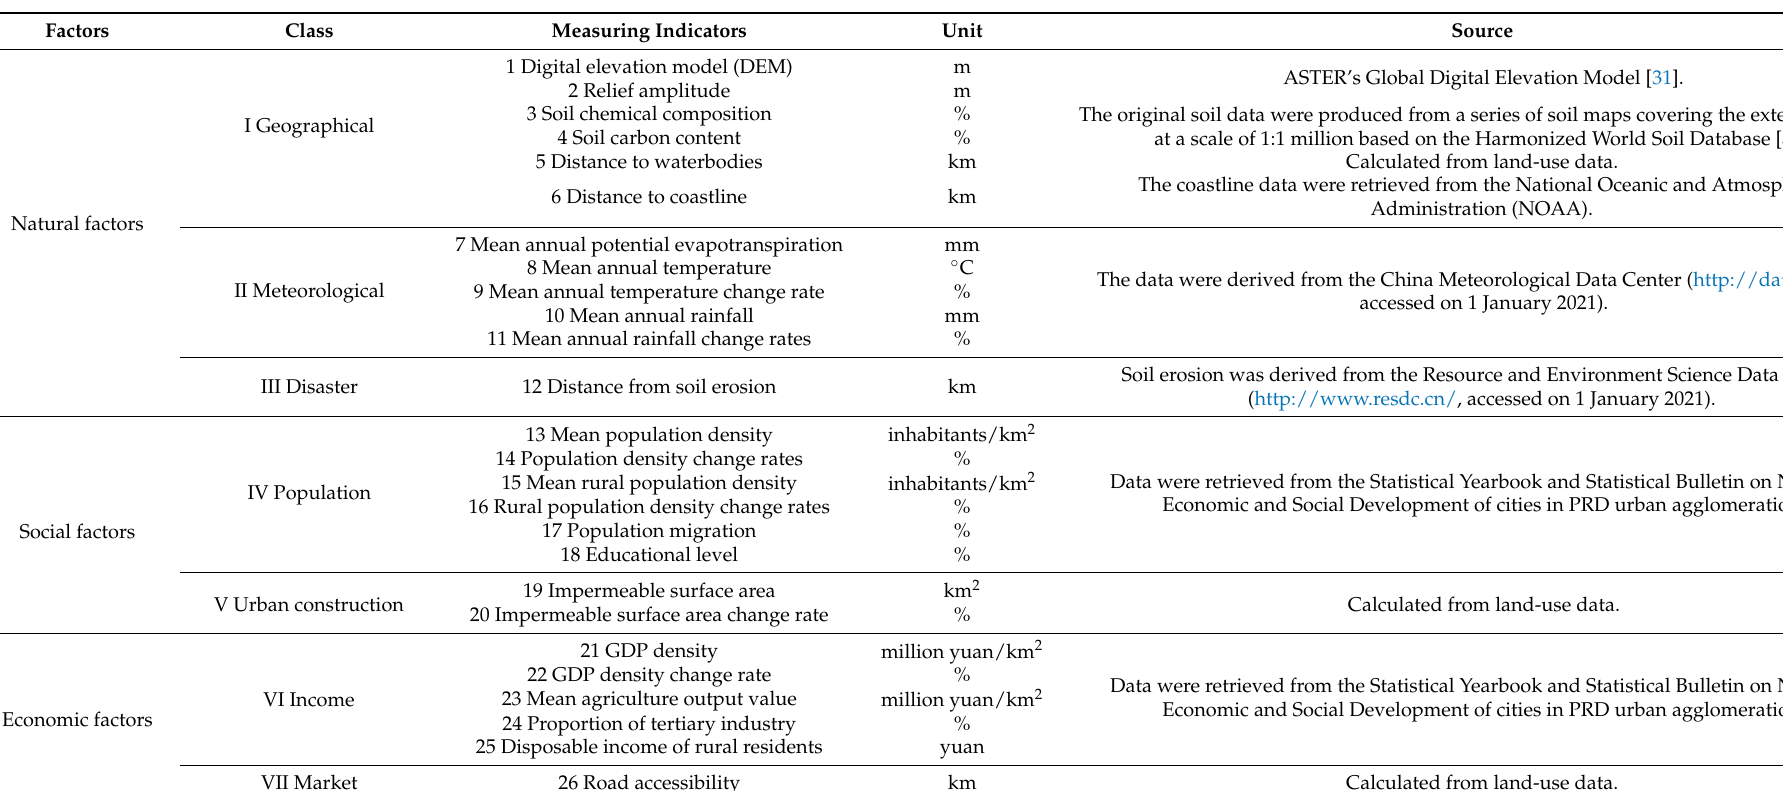
Table 1. Proxy variables of the compound